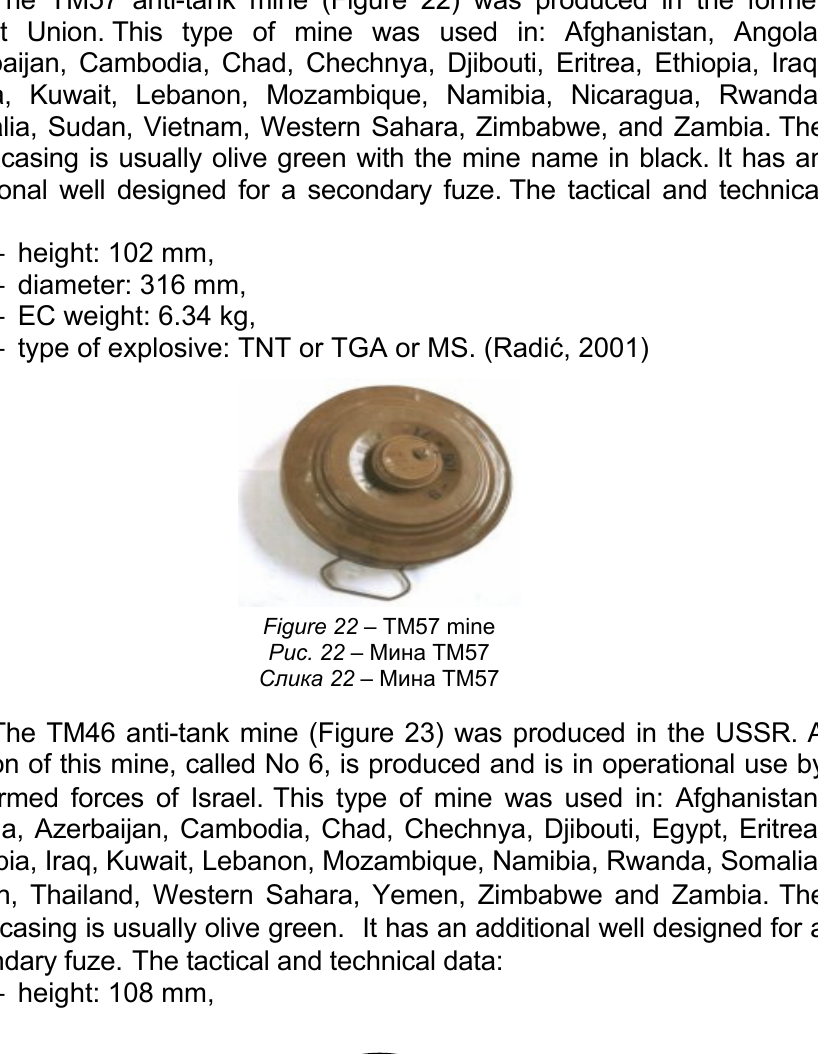
Figure 21 – M421 mine Рис . 21 – Мина М 421 Слика 21 – Мина M421